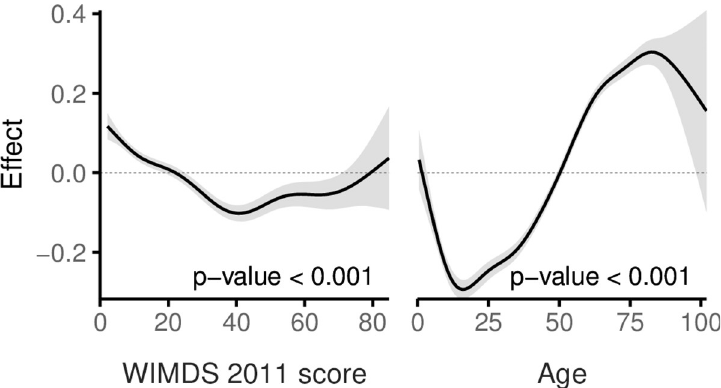
Fig 7. A GAM of AMR by the WIMD 2011 score and age, adjusted for gender. The shaded area represents the 95% CI of effect. AMR, asthma medication ratio; CI, confidence interval; GAM, generalised additive model; WIMD, Welsh Index of Multiple